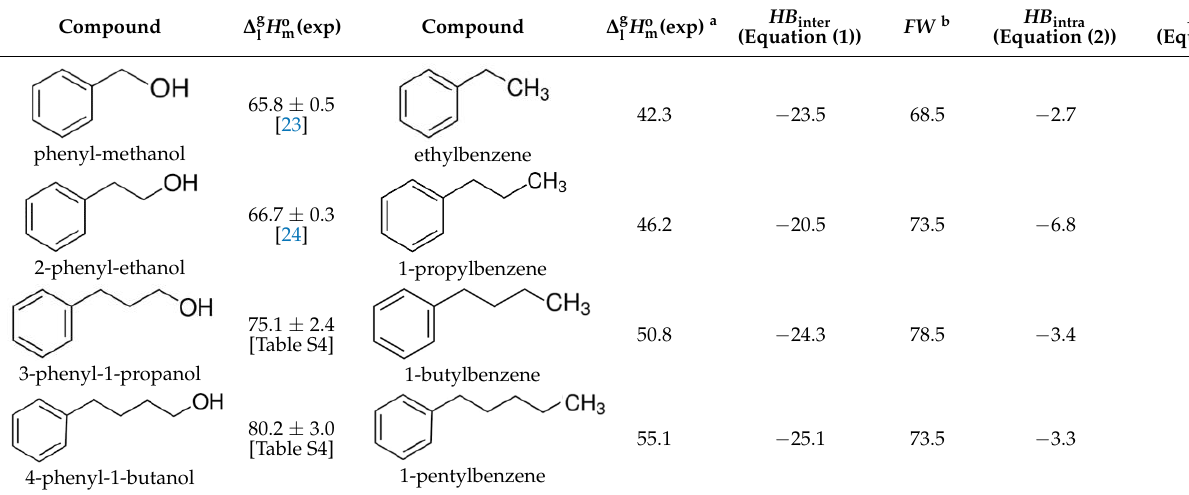
referred to the frameworks (see text).